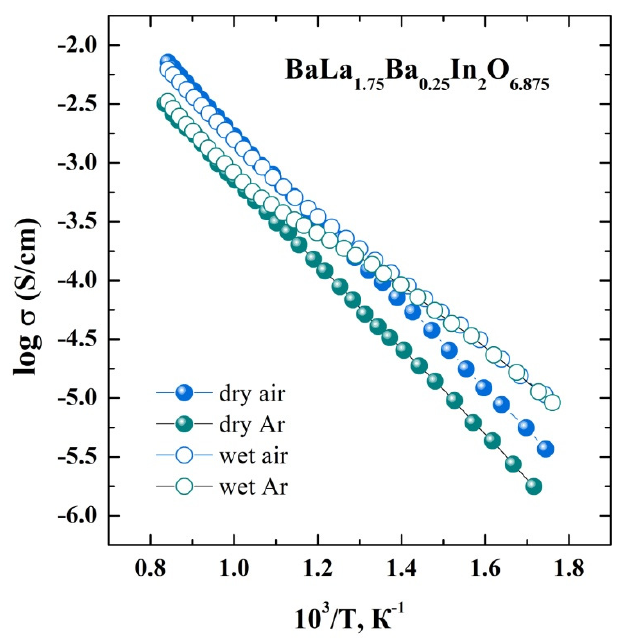
Figure 4. The temperature dependencies of conductivity for the composition BaLa 1.75 Ba 0.25 In 2 O 6.875 under dry (filled symbols) and wet (open symbols) conditions.